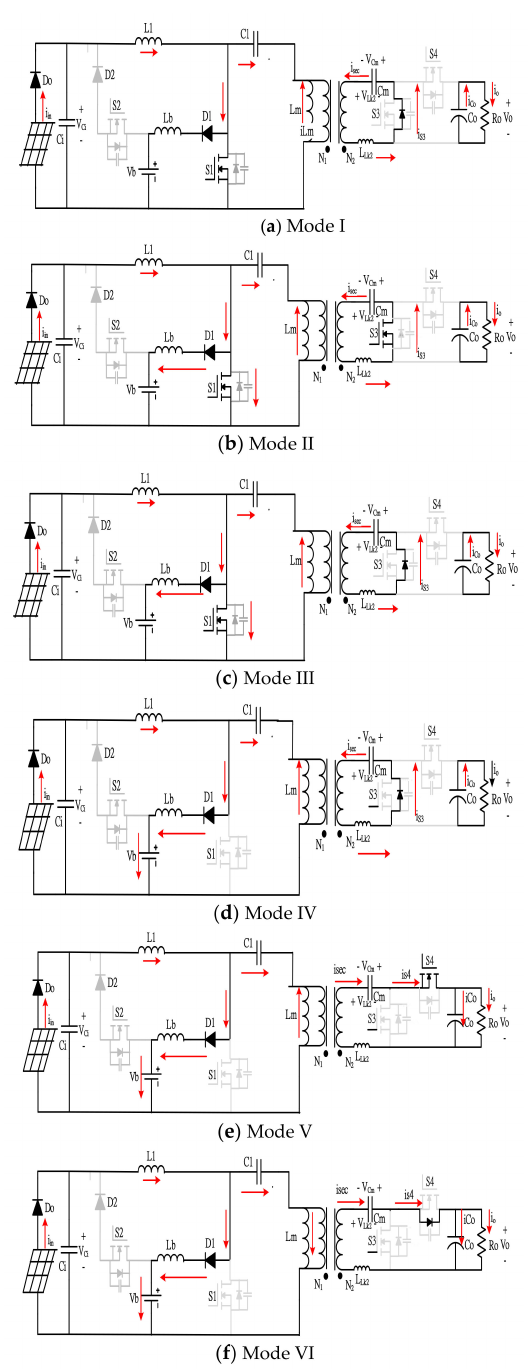
Figure 5. Operational diagram of each mode in Stage 1: ( a ) Mode I, ( b ) Mode II, ( c ) Mode III, ( d ) Mode IV, ( e ) Mode V, and ( f ) Mode